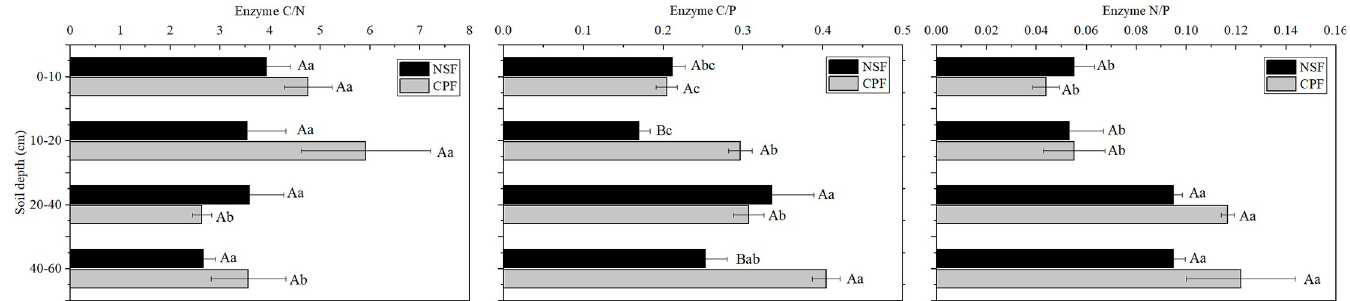
Fig 4. Variations of enzymatic stoichiometry at different soil depths of the natural secondary forest (NSF) and Chinese fir plantation forest (CPF). Capital letters mean the significant difference between the two forests at the same soil depth, and the different lower cases reflect the significant difference between soil depths within one forest. All values are presented as mean ± standard error with 3 replicates.